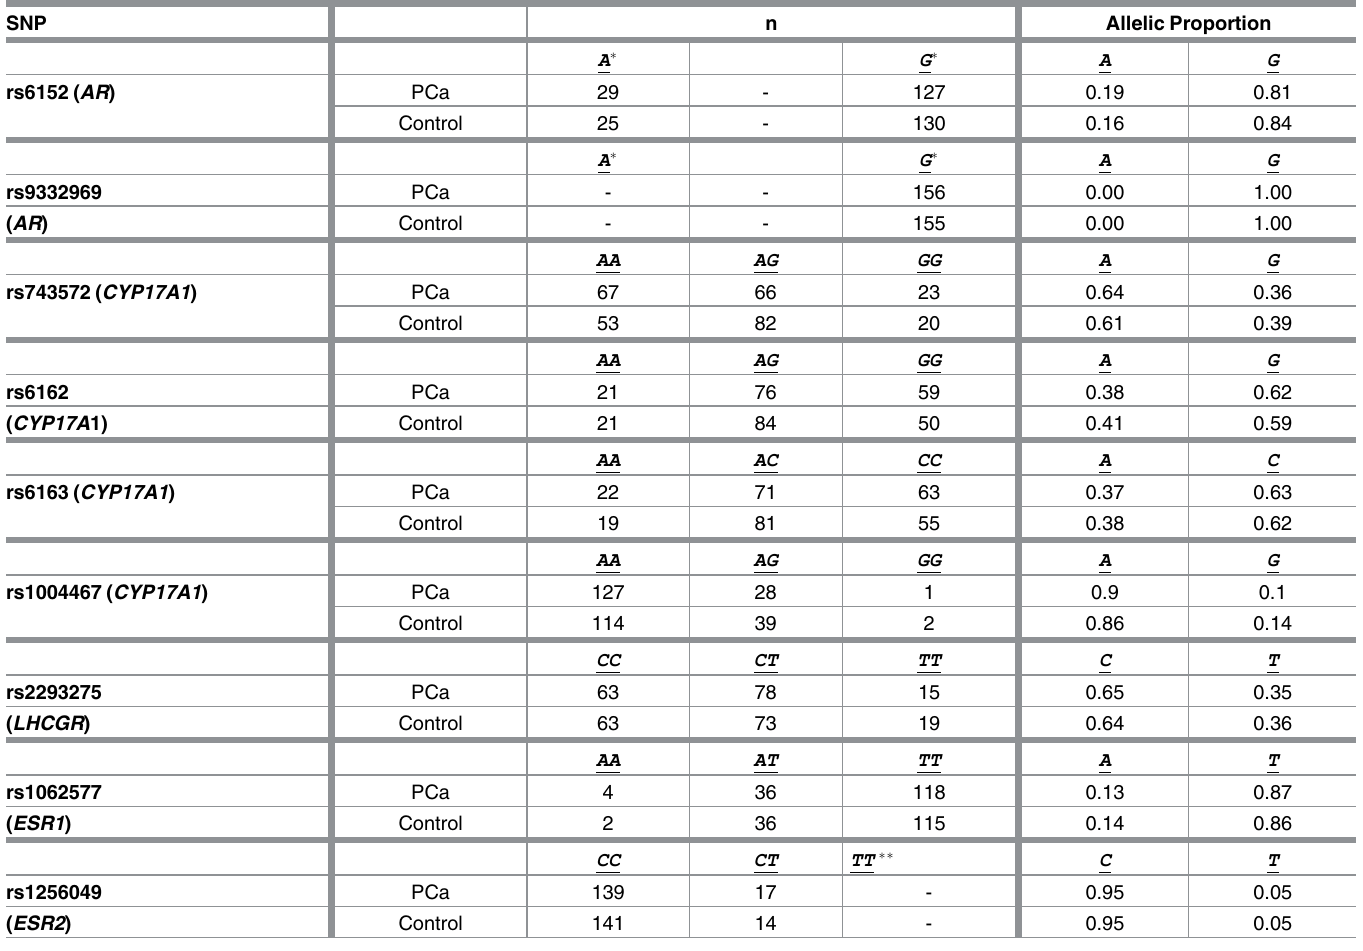
Table 2. Genotyping and Allelic Proportion of